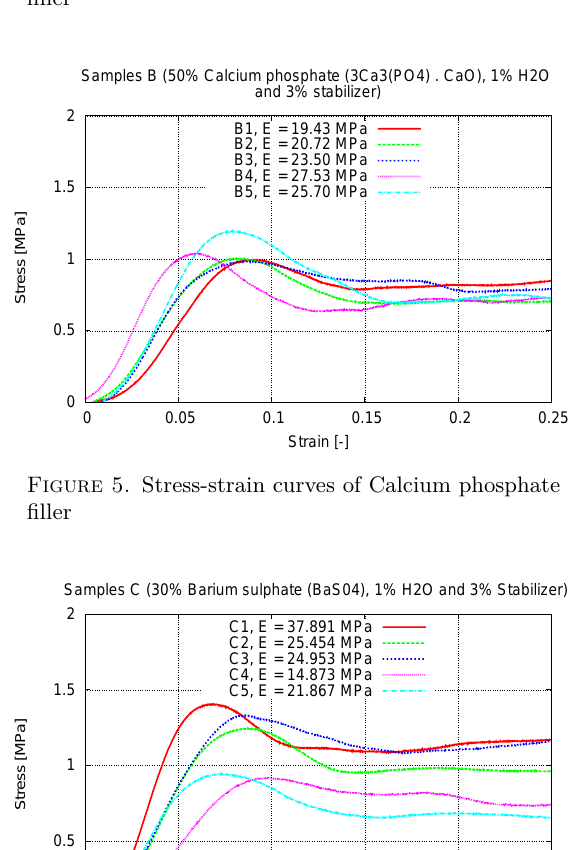
diagrams. For the yield stress σ